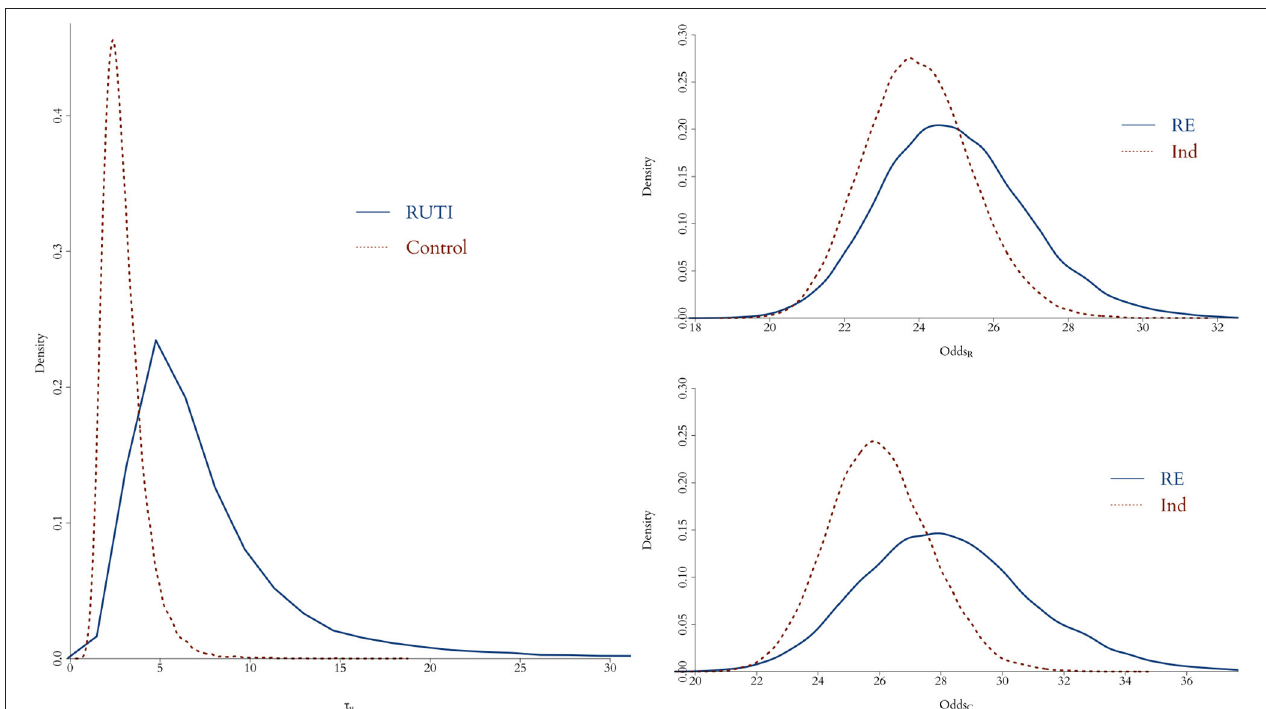
FIGURE 3 | Posterior distribution of odds for both RUTI (top left) and Control (bottom left) groups, when either using profiles with identical initial vector of features as individual patients (red dotted) or taking each profile with its corresponding 100 simulations as a replicate of a specific patient (solid blue). On the left panel, the posterior distributions of the random effect precision from each group is